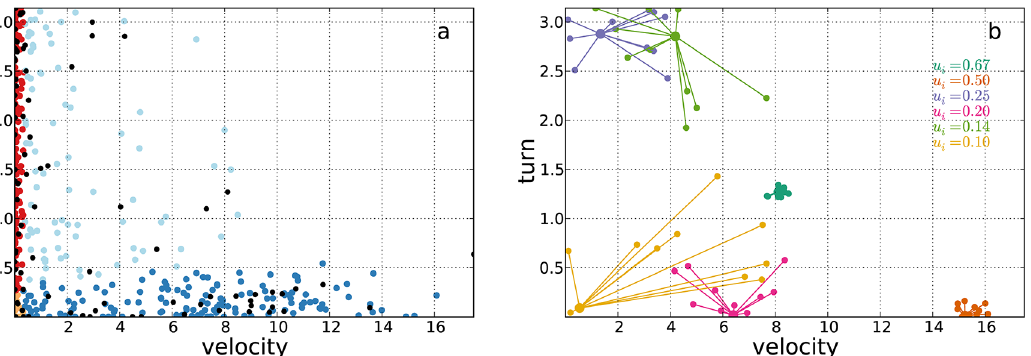
Fig 4. Procedures for robustness tests. Procedures used in the robustness tests. a) Data-loss: sub-sampled datasets are generated by assigning a uniform random value 0 (cid:2) p i (cid:2) 1 to each data-point and removing all those points with p i < k dl , with 0 (cid:2) k dl (cid:2) 1 being the data loss factor, (in this example k dl = 0.2, removed points are marked as black dots). b) Data-inaccuracy: jittered datasets are generated by jittering the data-points using a noise function based on the associated uncertainties Eqs (8) and (9); we show some example data points connected with several jittered versions of themselves with k di = 0.05, using different colours to identify the correspondences, and also to relate each one with its associated reliability u i indicated in the legend; note that the more unreliable is a data point the more different could have been its observed